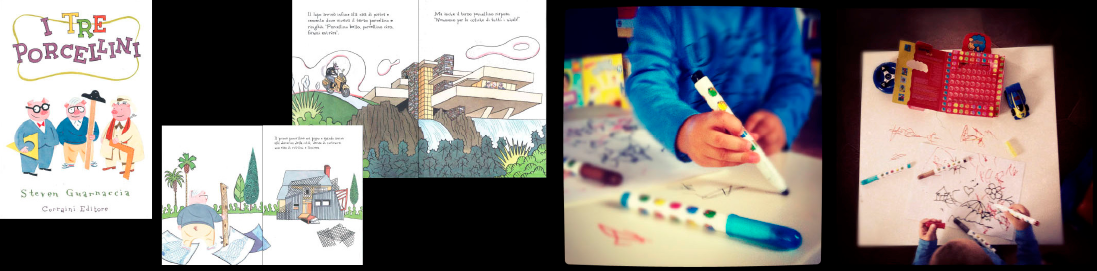
Figure 5. Images that enhance the narrative experience of the child (illustration for children) and experiential images in which they synthesize time and space (childish